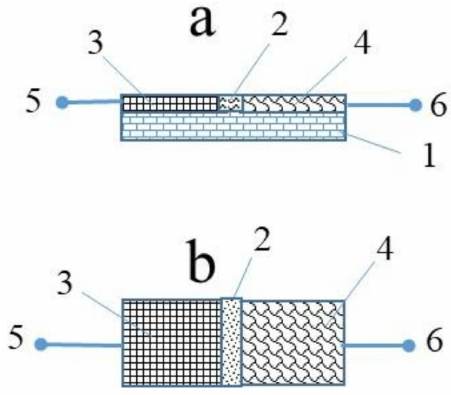
Figure 9. Schematic of the front view ( a ) and the top view ( b ) of the rubber based Al/OD-Gel/Cu composite flexible electrochemical cells: rubber substrate (1), OD–gel composite (2), Al electrode (3), Cu electrode (4), metallic terminals (5 and